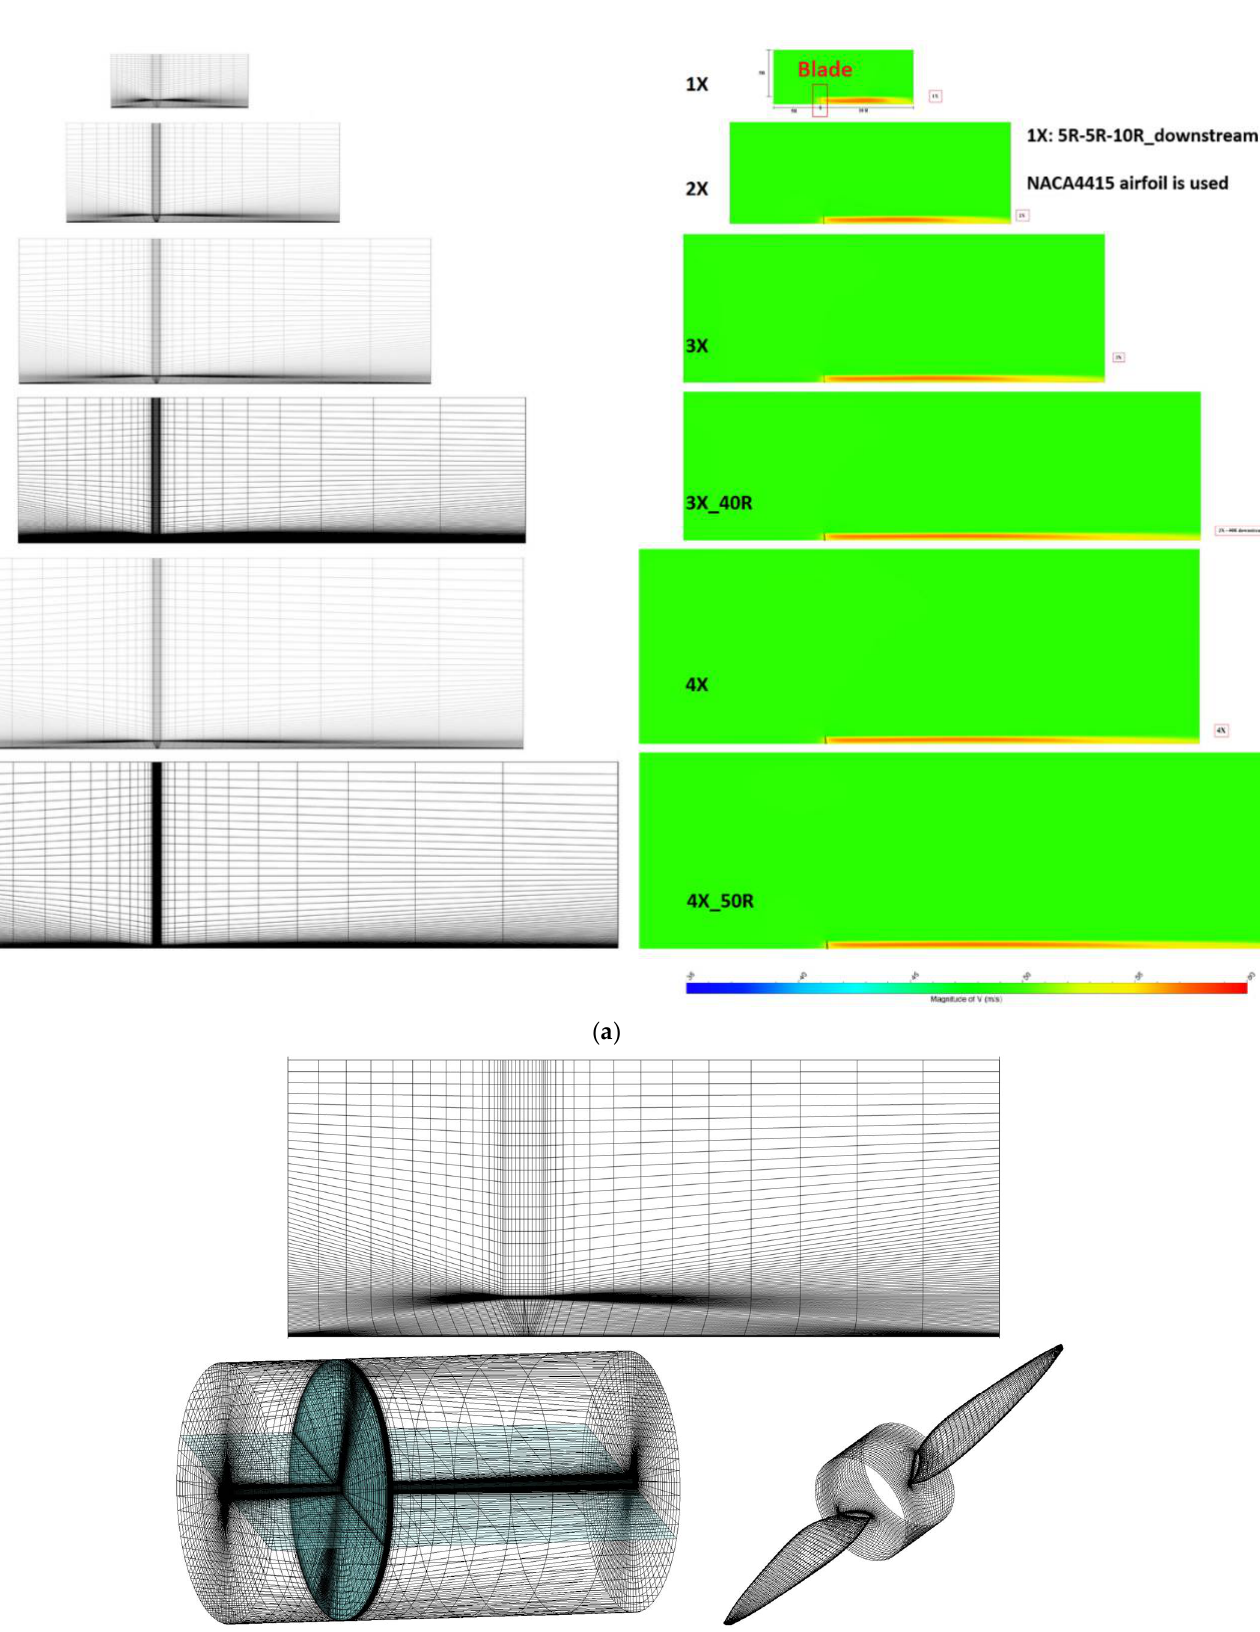
Figure 10. Grid convergence study for a propeller design in terms of thrust and torque with varying grid points.